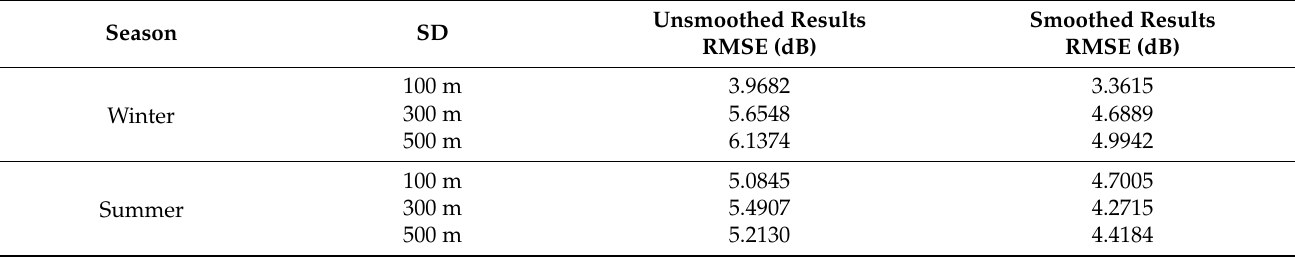
Table 4. Comparison between the TL calculated through the model and the actual situation at different seasons and different sound source depths (the frequencies were 50 Hz and 400 Hz,